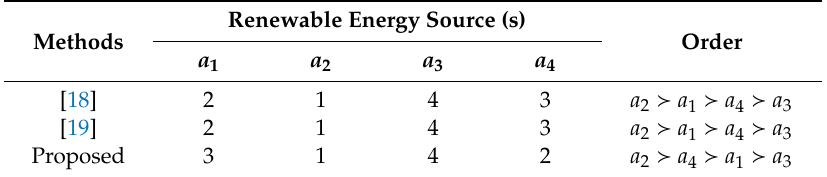
Table 6. The ranking order of renewable energy sources: Proposed vs. Others.